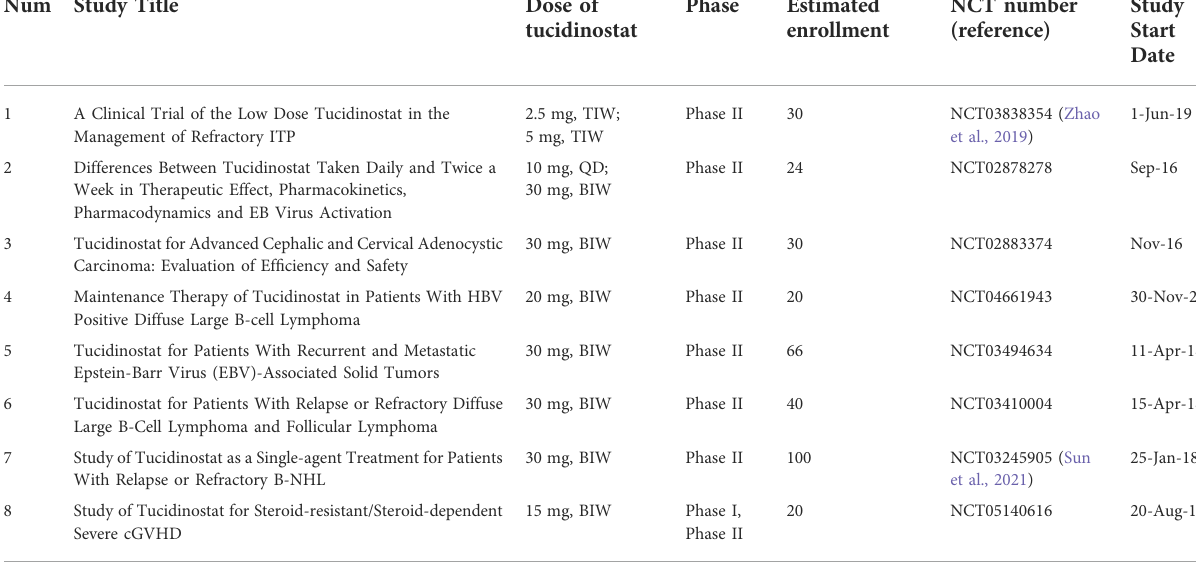
TABLE 2 Ongoing clinical trials of tucidinostat as